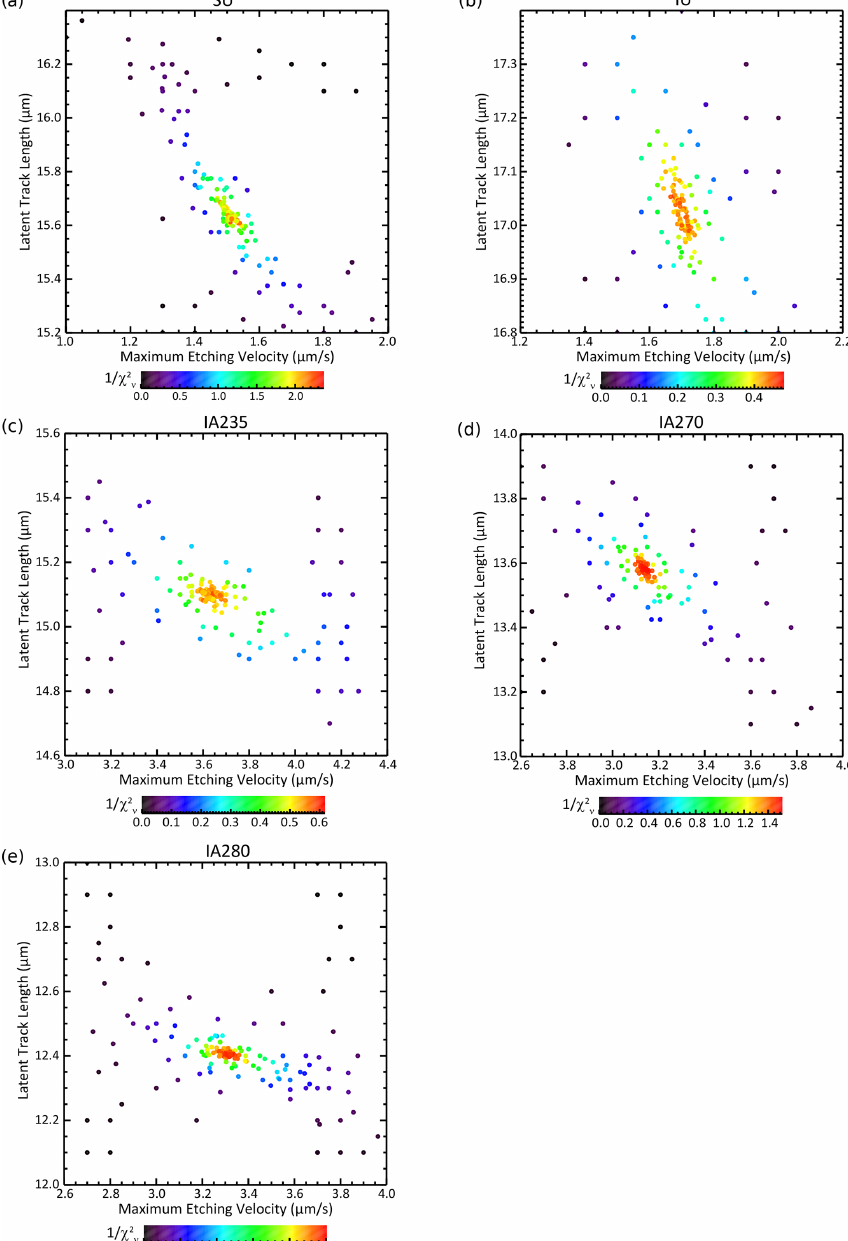
Figure 14. Linear model parameter fits; see Fig. 13 caption for